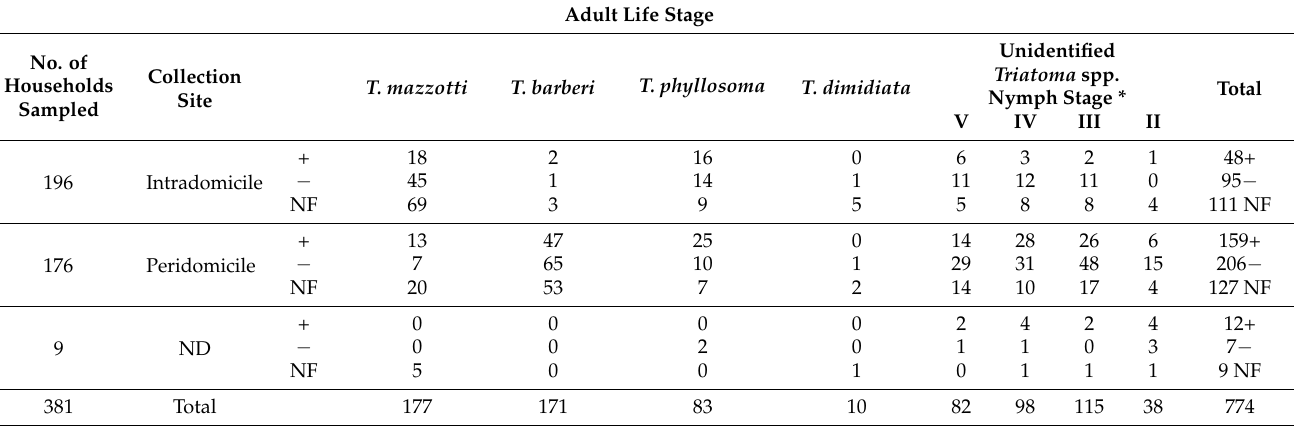
Table 2. Triatoma spp. infected or not with Trypanosoma cruzi found in intradomicile or peridomicile in Oaxaca, M é